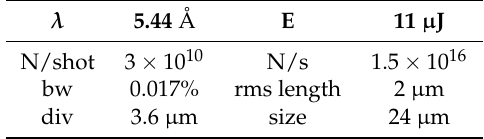
Table 5. Characteristics of the radiation of a 5 × 5 cascade seeded by a FEL oscillator. Symbols are explained in Table 3.